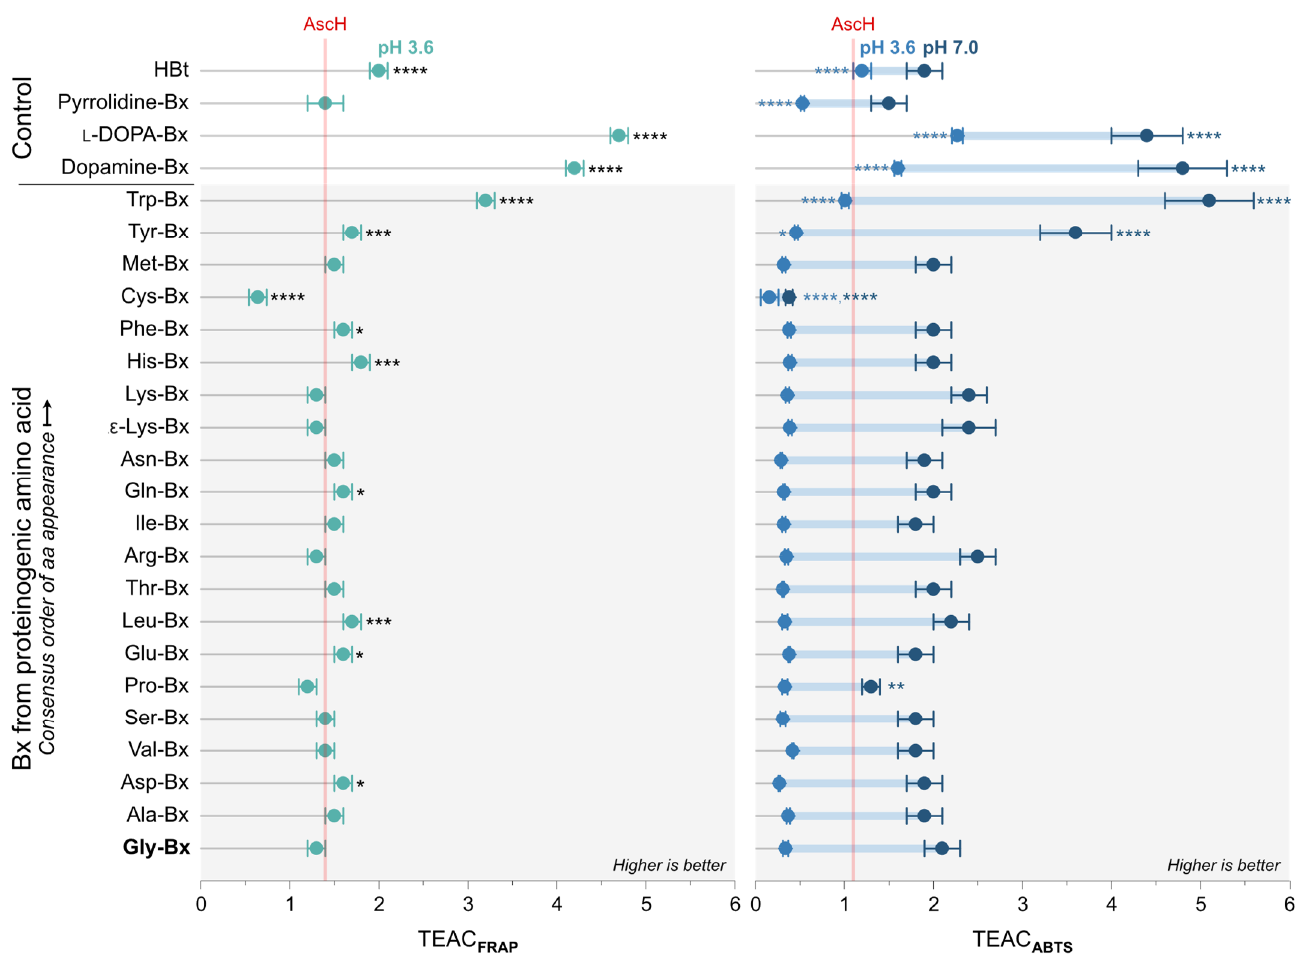
Figure 4. Trolox equivalent antioxidant capacity (TEAC) of betalamic acid and betaxanthins derived from L -amino acids, dopamine, and pyrrolidine determined by the FRAP method at pH 3.6 and by the ABTS assay at pH 3.6 and 7.0. Raw data are presented in Figures S30–S33. Asterisks indicate values that are different from those of Gly-Bx (ANOVA-Tukey test, 95% confidence interval, * p < 0.05, ** p < 0.01, *** p < 0.001, **** p < 0.0001, N = 3).